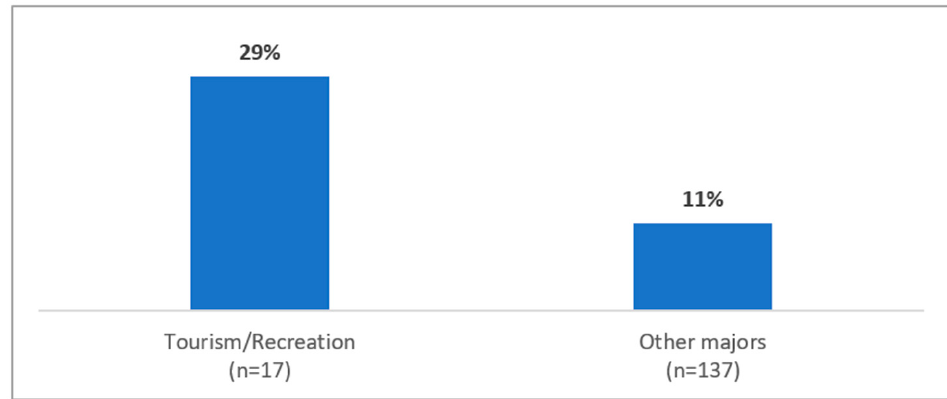
Figure 14. Networking opportunities by type of major.